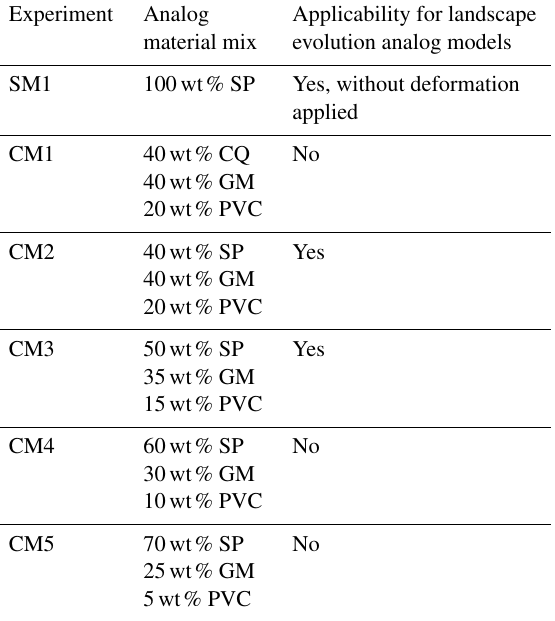
Table 1. Material used in experiments. The label CM indicates a composite material, while the label SM indicates a pure single ma-